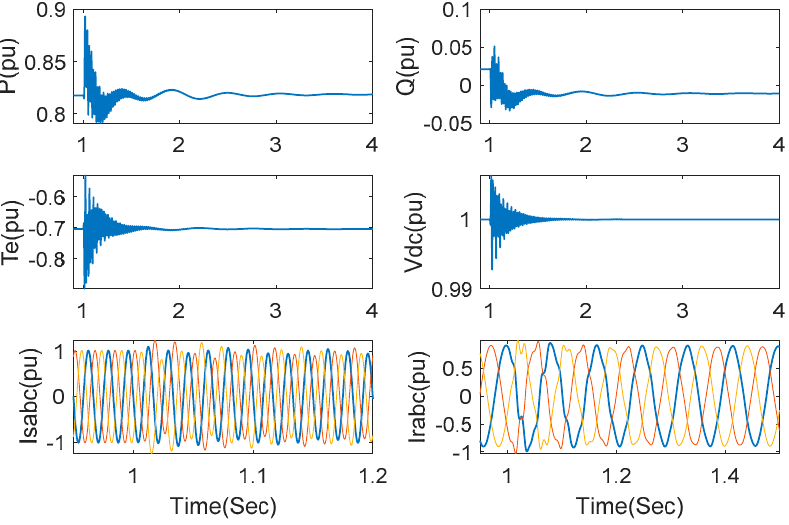
Figure 10. Responses under the proposed method with internal parameter perturbation (series compensation 75% and wind speed 15